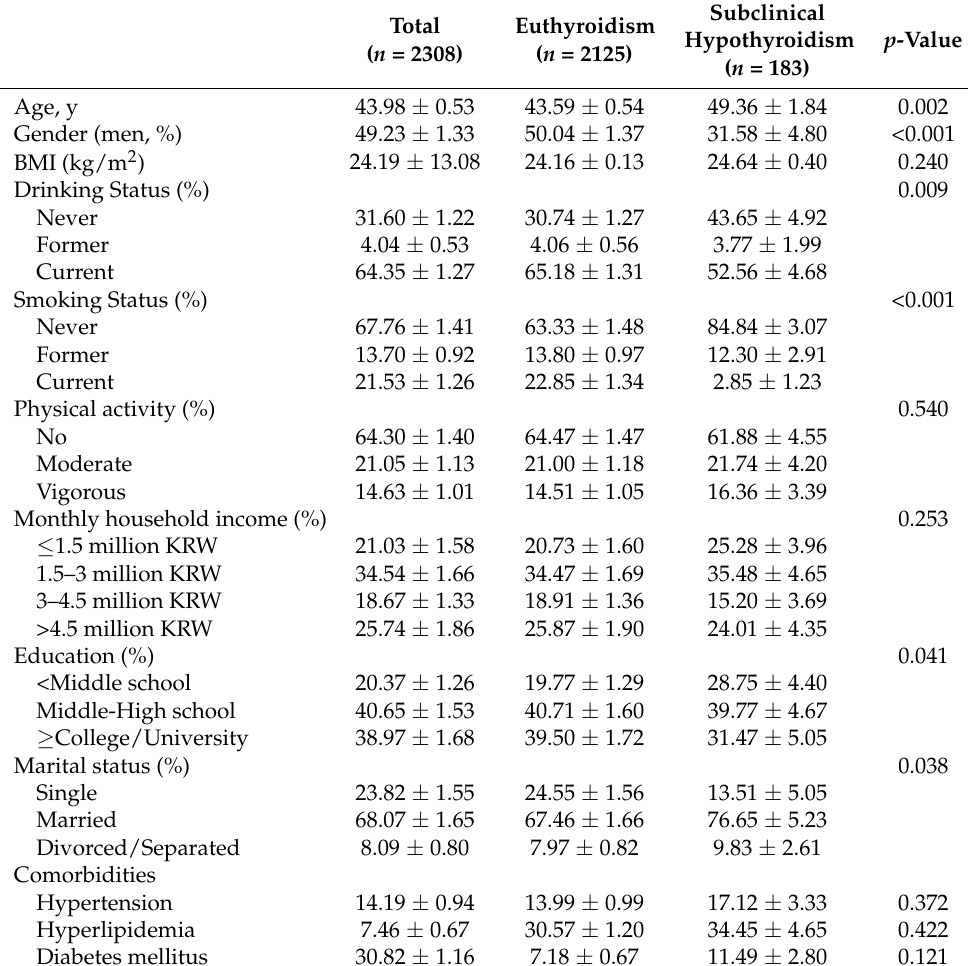
Table 2. General characteristics of the study participants based on the thyroid